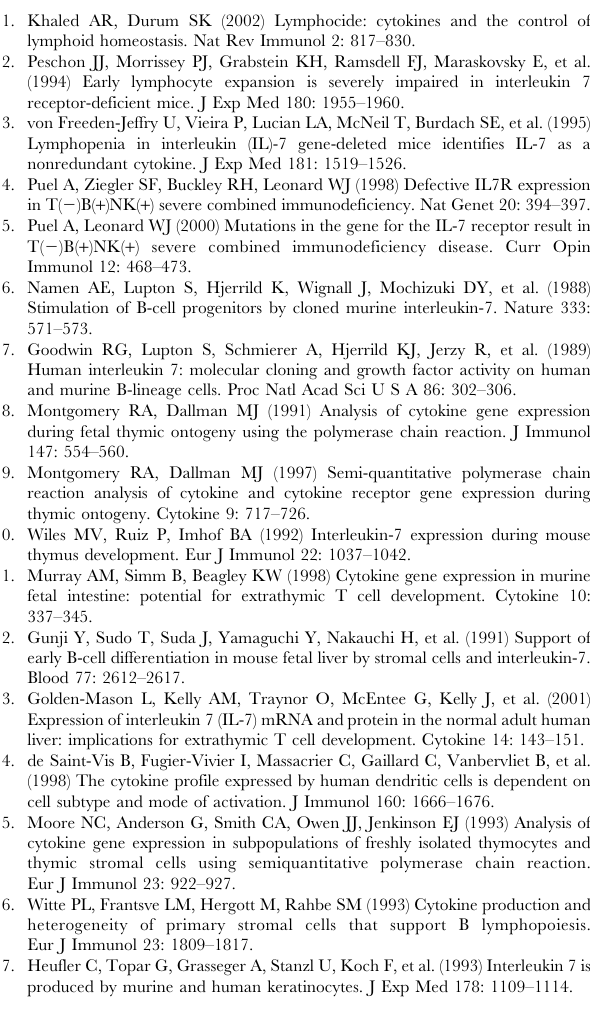
Twenty-four hours later, bone marrow was harvested from the long bones, stained with anti-CD8 and analyzed by flow cytometry. A. Three individual recipients are shown for each treatment. No inhibition of migration of OT-1-TCM cells resulted from blocking CXCR4 or deleting Il7. Note that the IL-7 2 / 2 recipient lacked endogenous CD8 cells. B. The data is shown in numerical form representing the total number of OT-1-TCM cells recovered per individual mouse. Table S1 OT-1-TCM association with ECFP producers. Data are corrected by removing OT-1 whose center overlies a stromal cell (probable spill-over artifact). Found at: doi:10.1371/journal.pone.0007637.s004 (0.03 MB DOC) Movie S1 Central memory cells (TCMs) were obtained by in vitro differentiation of T cells from OT-1xRAG 2 / 2 mice. TCMs were labeled with CFSE and injected intravenously twice ( 2 24 hr and 2 2 hr) into IL7promECFP mice. Bone marrow was visualized by intravital microscopy. CFSE labeled TCMs (green) exit the blood stream (red) and some interactions with ECFP producing cells (blue) were observed. The video spans a 40 minute time.